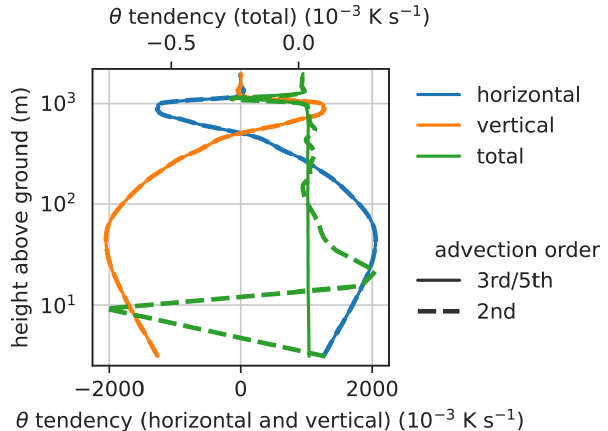
Figure 4. Profiles of total θ tendency (resolved + subgrid-scale) on the ridge at x = 0, for the averaging period between 3.5 and 4h af- ter initialization resulting from flux derivatives in the x (blue, lower x axis) and z (orange, lower x axis) directions and their sum (green, upper x axis) calculated with second-order advection (dashed) and third- (vertical) and fifth-order (horizontal) advection, consistent with the numerical model (solid).